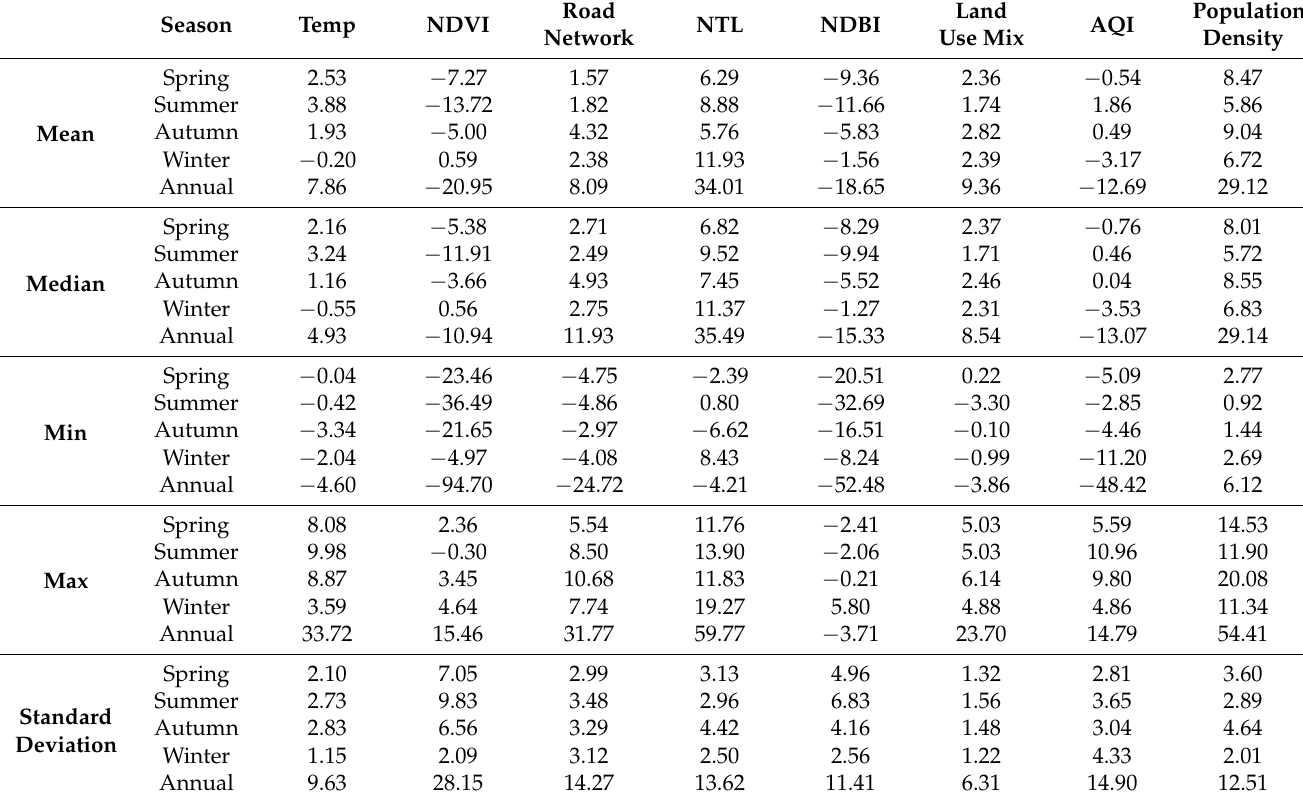
Table 3. Descriptive statistics of the regression coefficients in the GWR